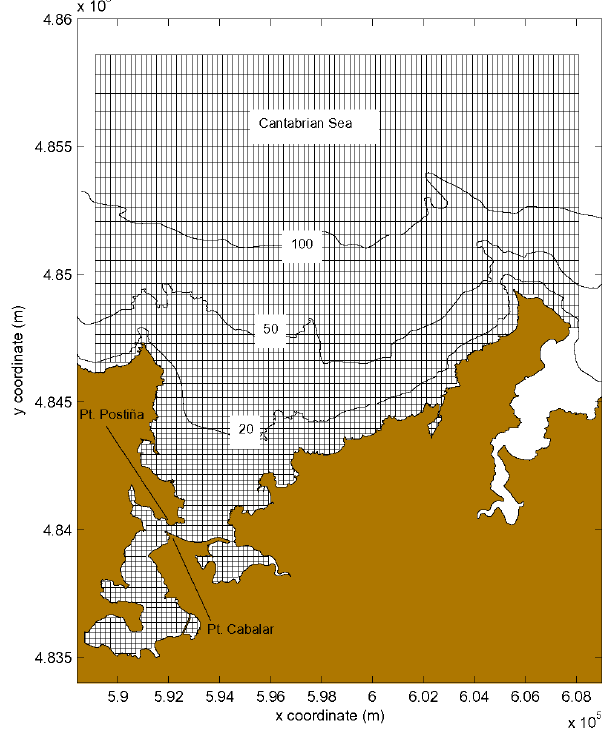
Figure 2. Numerical model grid.